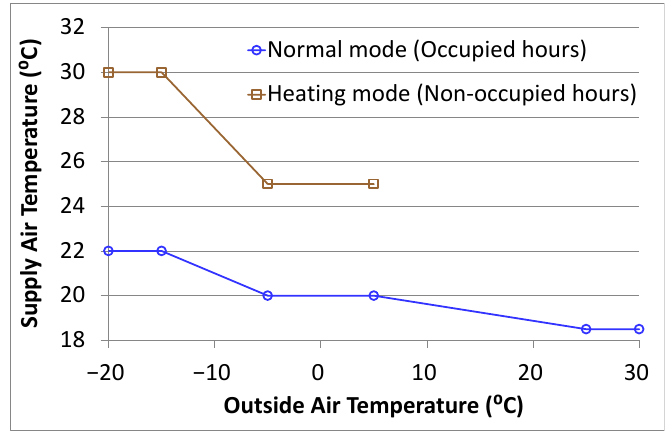
Figure 3. Supply air temperature as a function of outdoor air temperature.